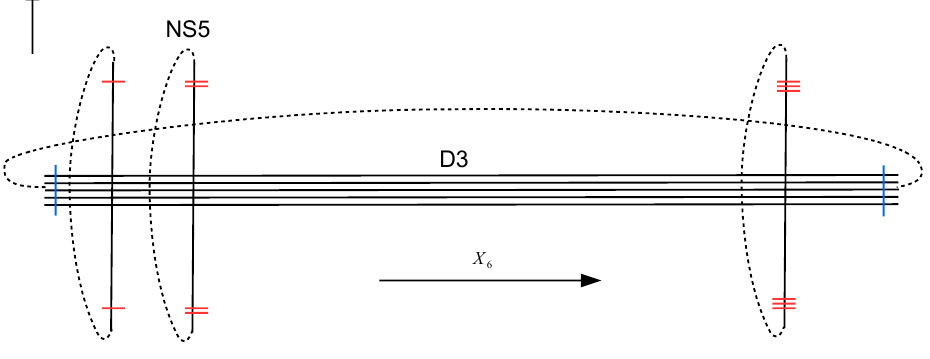
= 4 theory capturing the Coulomb branch of our original